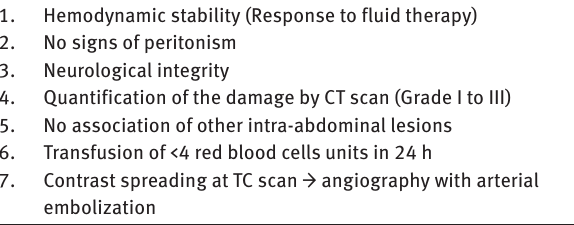
Table 2: Most important decision-making factor in favor of treatment against